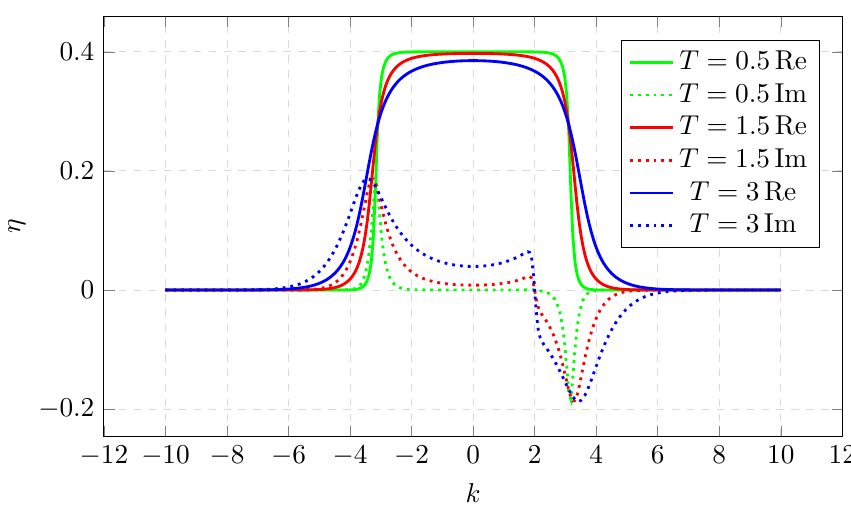
Figure 11: Solutions for η (cid:34) ( k ) from (132), at varying temperatures in the Fermi- Dirac distribution (23). The left and right limits of η ( k ) happen to be each other’s complex conjugate, for this quasi-kernel. The plots were generated with shift ν = 0.4, speed x / t = 2, density N / L = 1, and ε = 0.1. The sigmoid used is S ( k ) = erf k . ν modulates the amplitude while x / t marks the point of inversion and (cid:34) scales the slope of inversion in the imaginary